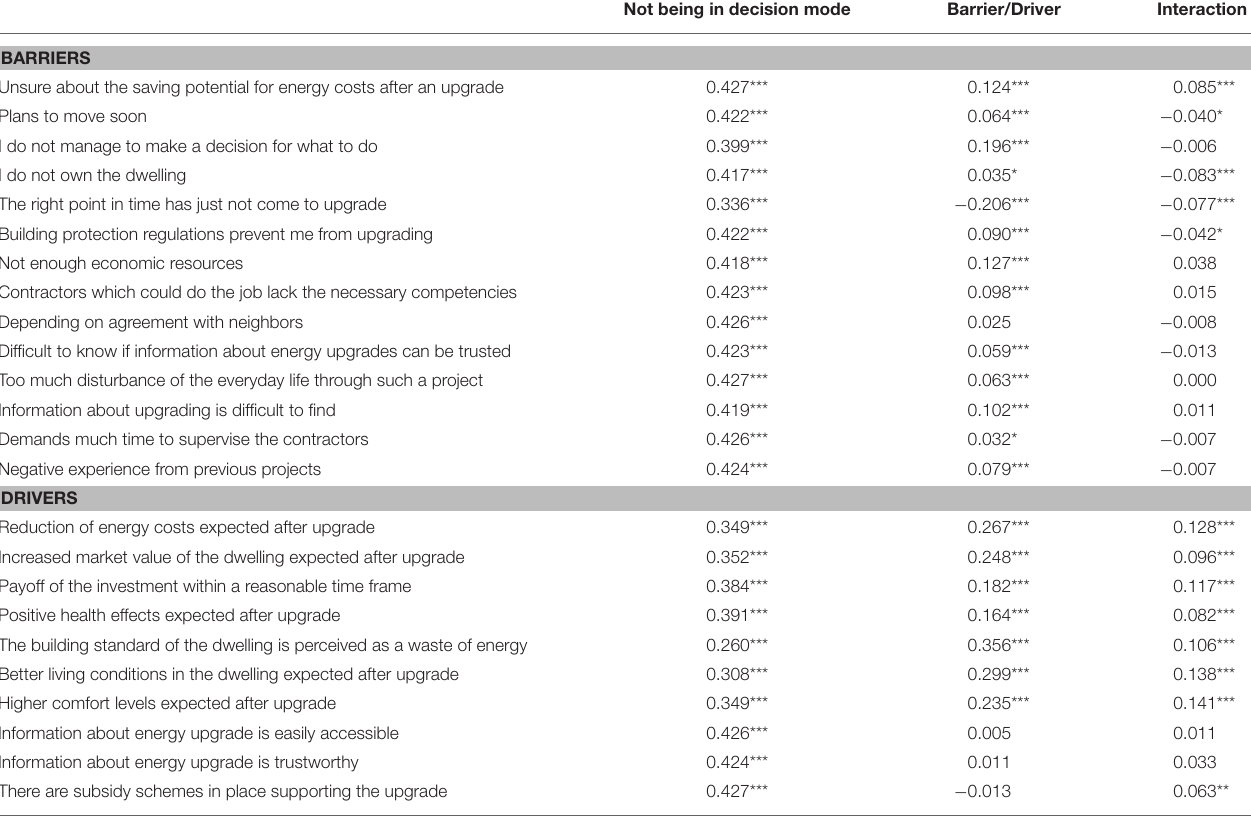
TABLE 3 | Analysis of the moderating effects of barriers and drivers on the transition from not being in decision mode to deciding what to do ( N = 3.787). Not being in decision